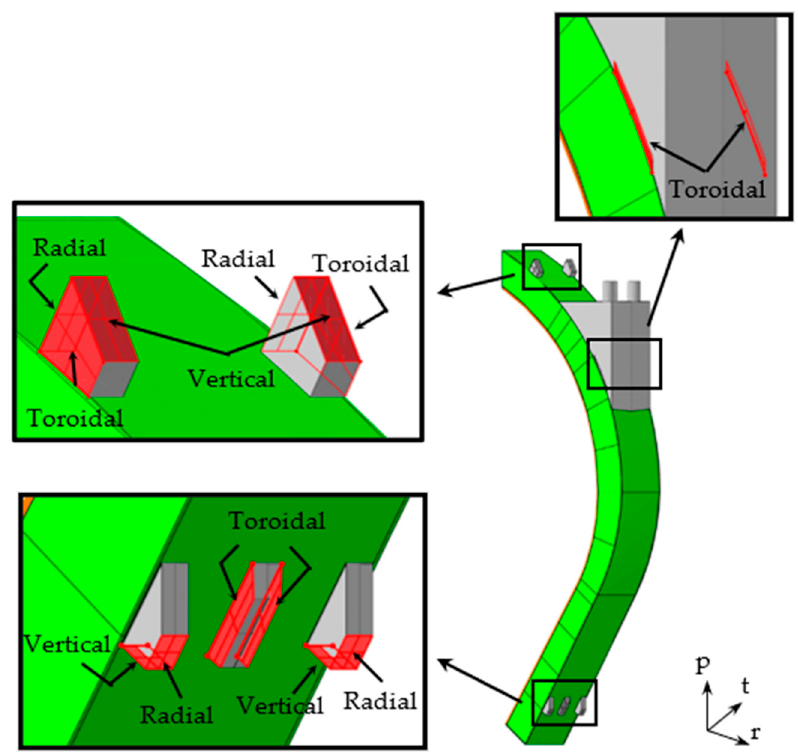
Figure 10. WCLL COB attachment system and indication of the directions of action of the springs.